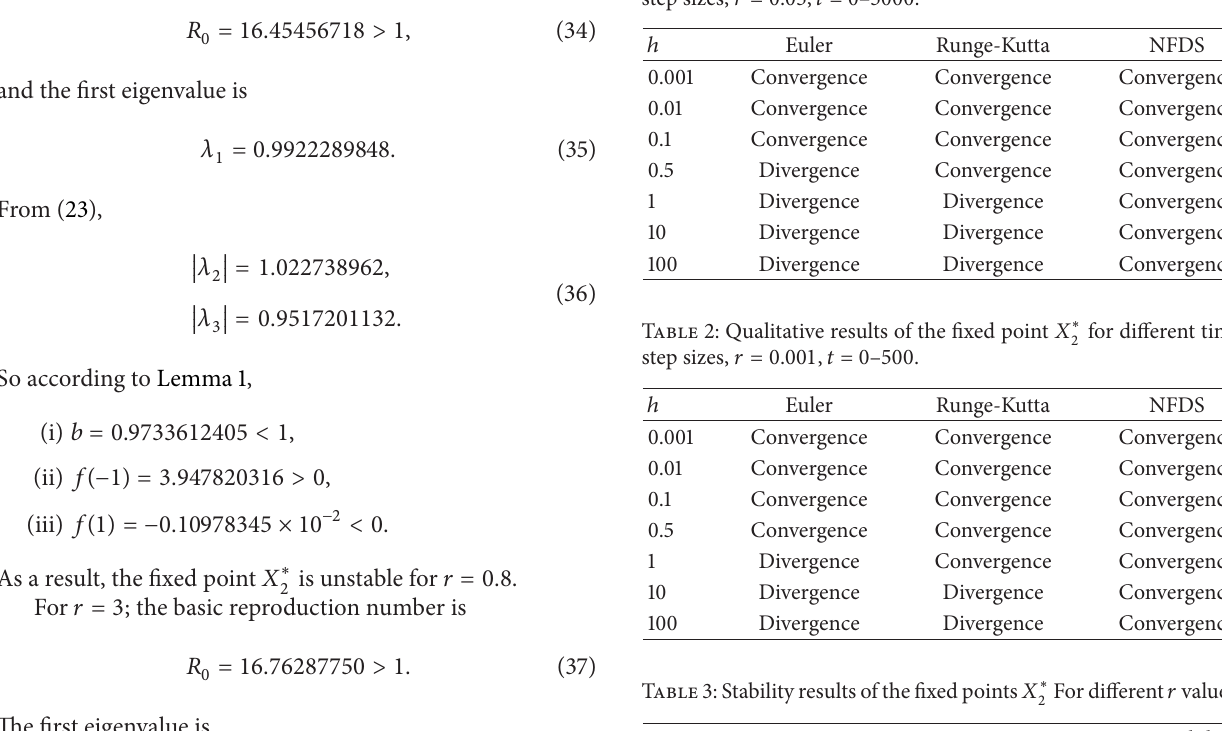
Table 1: Qualitative results of the fixed point 𝑋 ∗ 3 for different time step sizes, 𝑟 = 0.05 , 𝑡 = 0–5000.